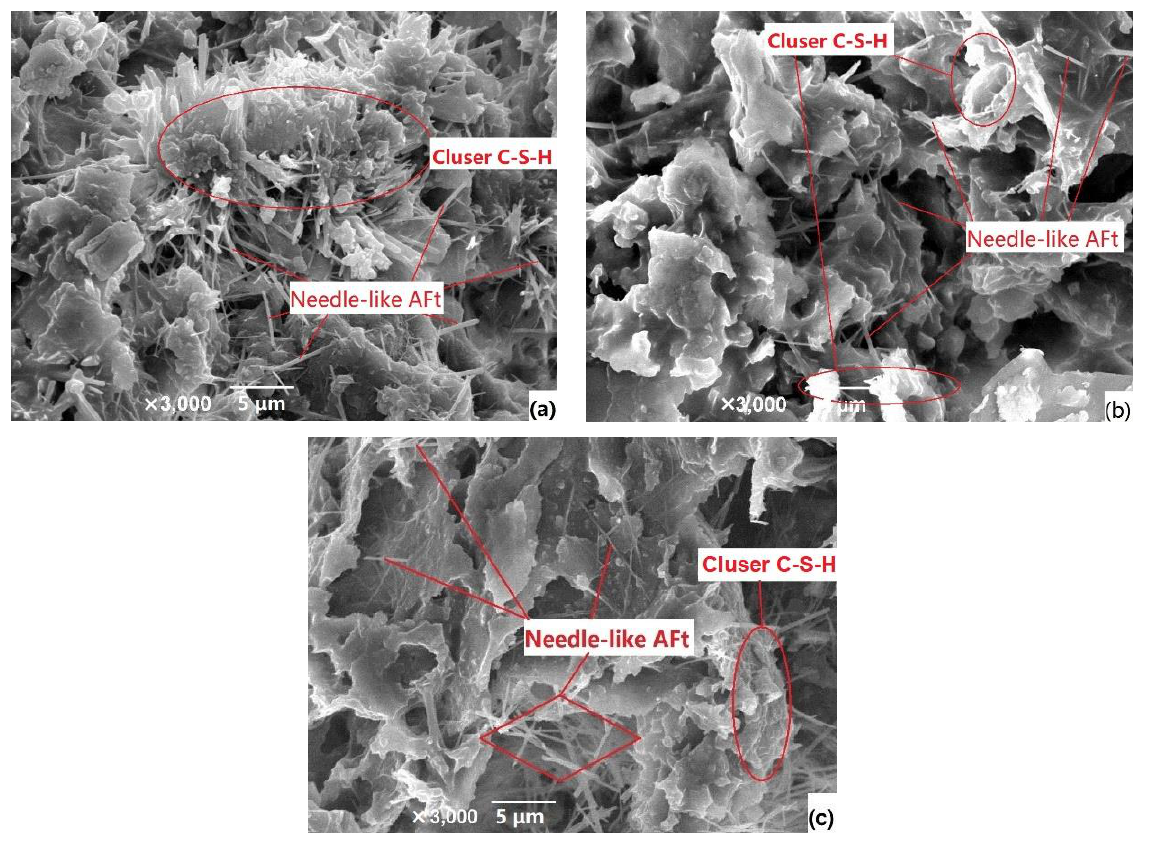
Figure 7. Morphology of aggregate surfaces of mixtures. ( a ) G1 mixture. ( b ) G3 mixture. ( c ) G3-2 mixture.